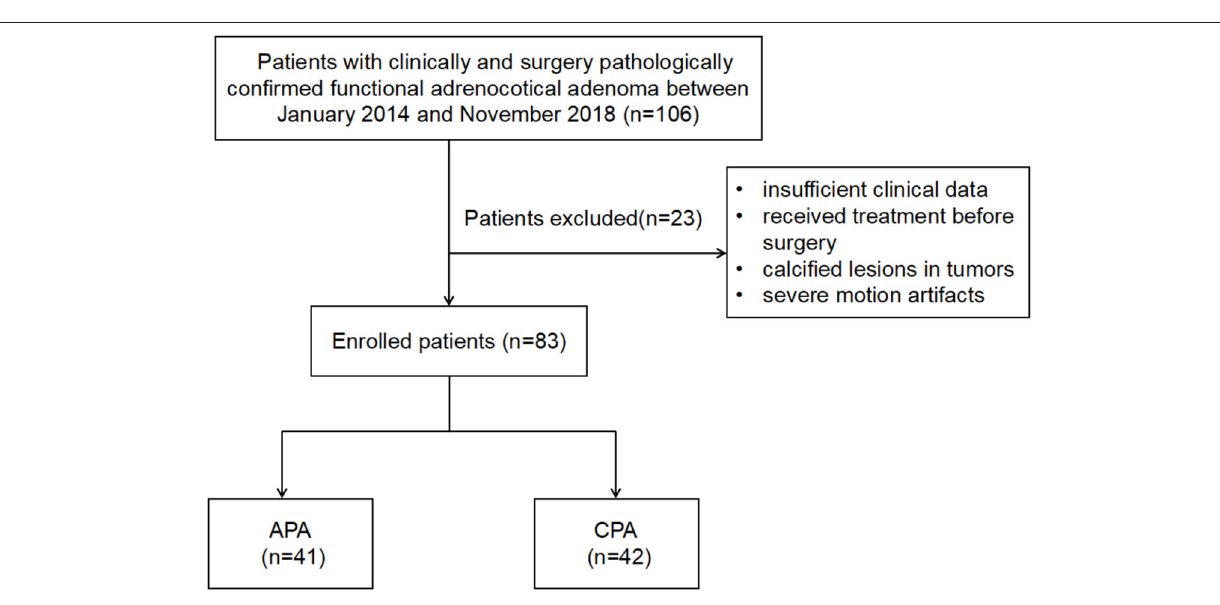
FIGURE 2 | The illustration of inclusion and exclusion